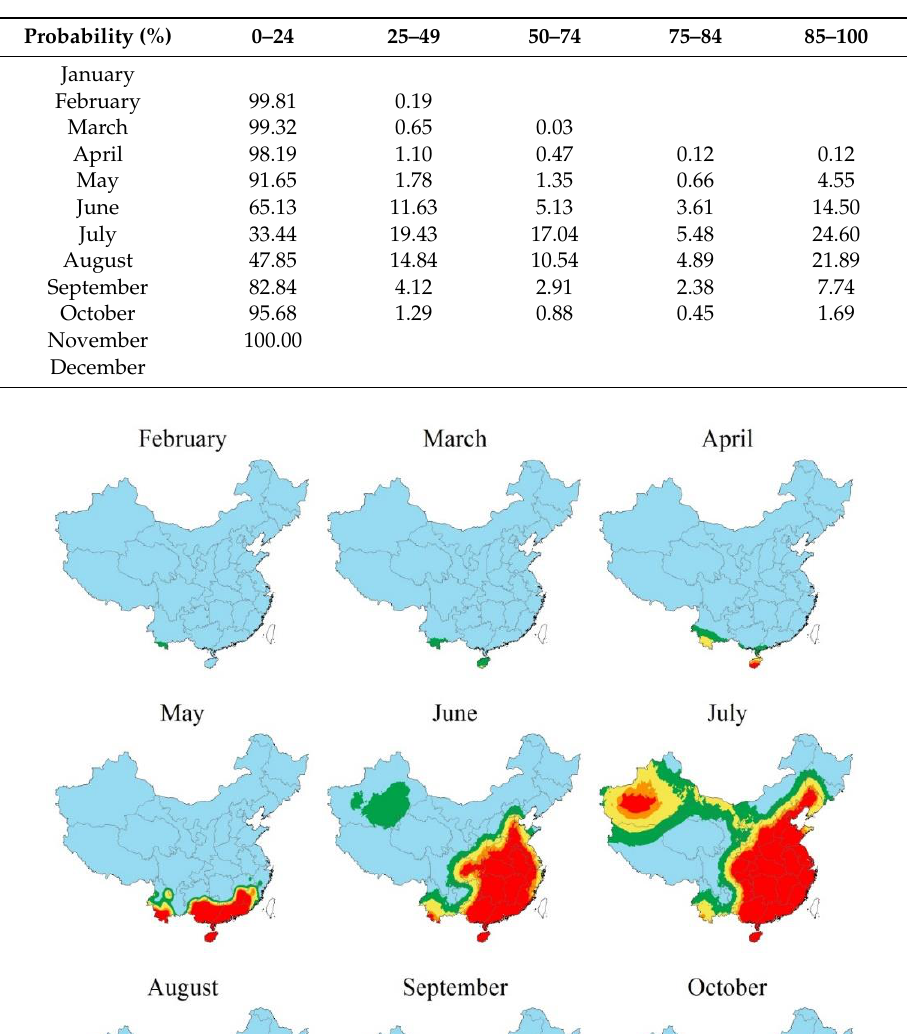
Table 3. Classification of calculated probability values and area distribution (%) by month.